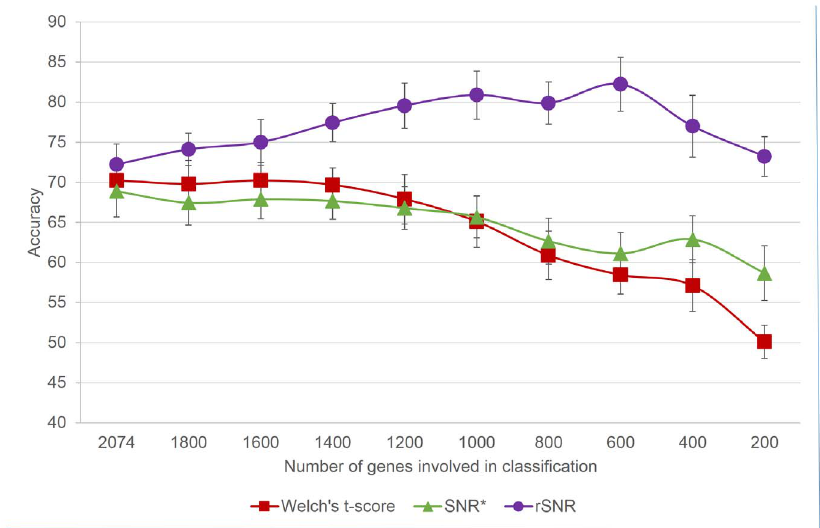
Figure 6. Cross-validation results of the comparison between rSNR and other feature selection methods on the AtGenExpress dataset. Error bars indicate 1 standard deviation away from the mean.